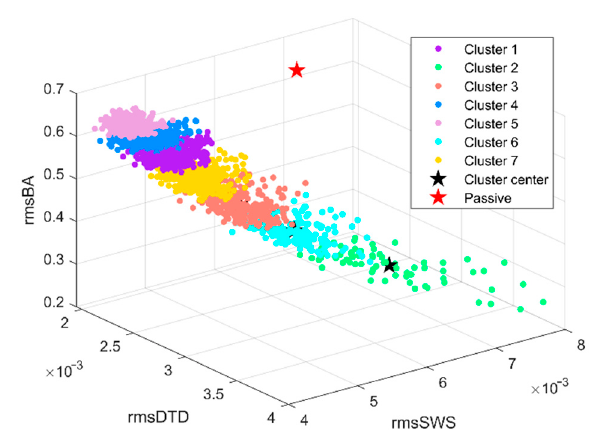
Figure 10. Clustering results of B-20 subsets. Table 5. Averages of clustering results of B-20 subset.